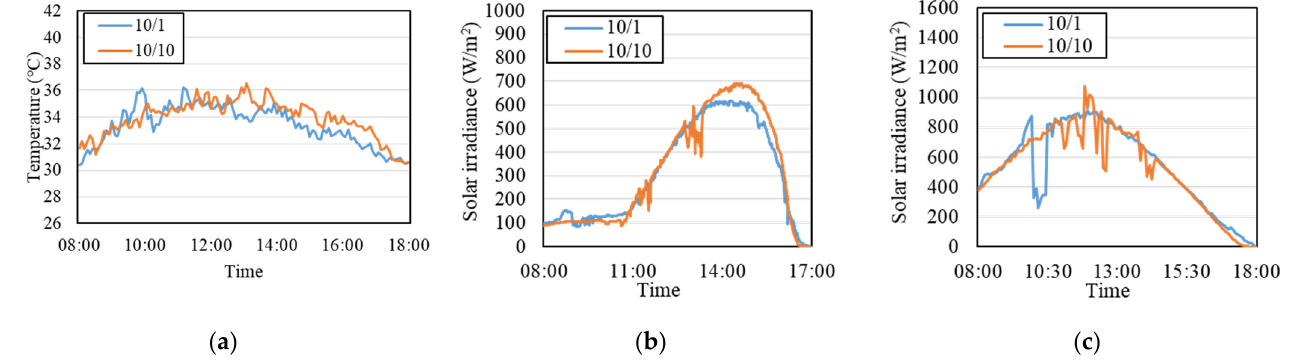
Figure 9. External conditions for measurement days. ( a ) Outdoor temperature; ( b ) Direct normal irradiation (facing west); ( c ) Global horizontal irradiance.